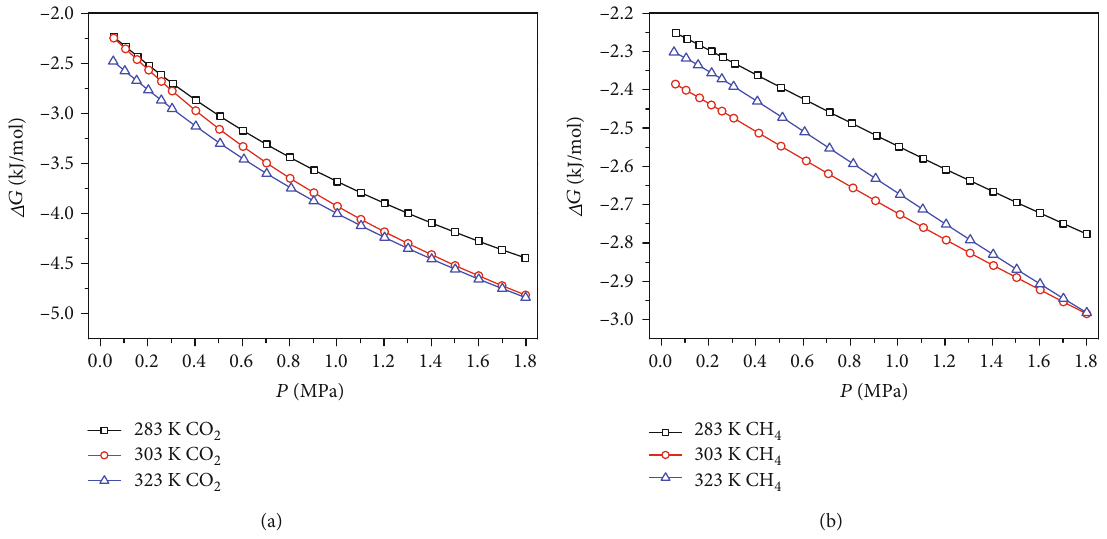
Figure 9: Gibbs free energy changes of CO